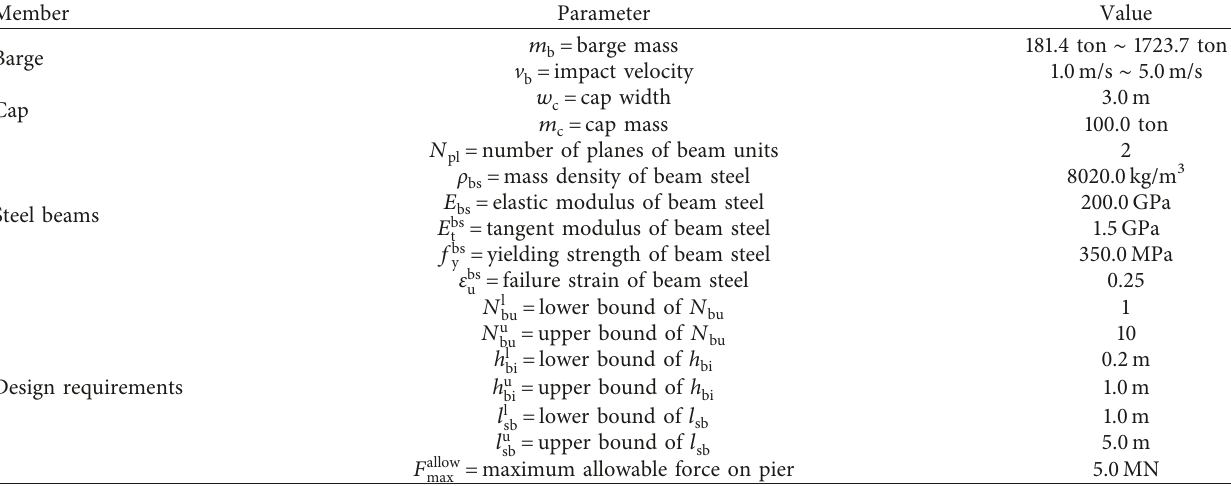
Table 4: Prespecified parameters for structure